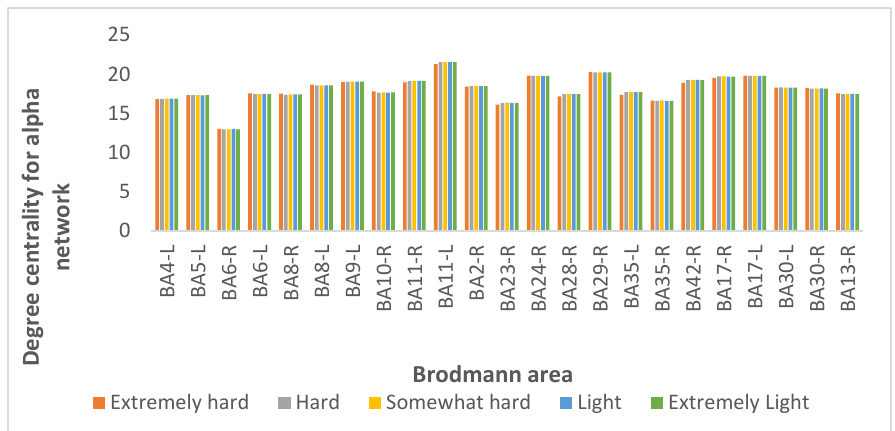
Figure 15. Results for degree centrality for the alpha coherence network at exertion levels extremely hard (orange), hard (gray), somewhat hard (yellow), light (blue), and extremely light (green). From 84 BAs, we selected the 30% with the highest degree centrality values for all subjects at all exertion levels for the beta coherence, as shown in Figure 16. For all exertion levels, the precentral gyrus region of the frontal lobe, corresponding to BA 44, was the most important node in the beta network in terms of the number of edges incident upon a node.